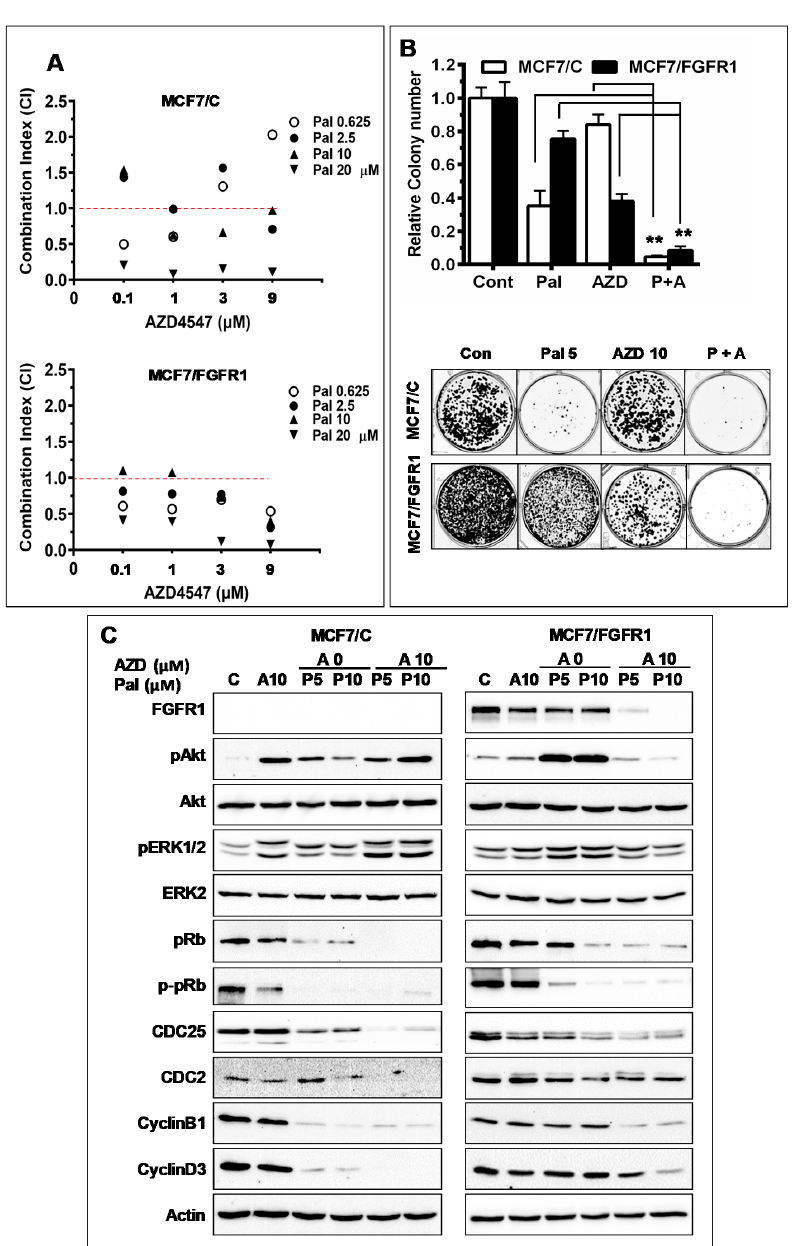
Figure 5. Effect of AZD4547 combination on palbociclib-induced inhibition of proliferation and sig- naling in MCF-7/C and MCF-7/FGFR1 cells. ( A ) Combination with AZD4547 synergizes palbociclib- induced inhibition of cell proliferation. MCF-7/C and MCF-7/FGFR1 cells were treated with pal- bociclib (0, 0.625, 1.25, 2.5, 5, 10, 20 µ M) ± AZD4547 (0, 0.1, 0.3, 1, 3, 9 µ M) for 5 days, followed by XTT assays. The survival fractions for each cell line were normalized to the control. The combination index (CI) of palbociclib and AZD4547 from the XTT assays for each cell line was calculated using CompuSyn software. The spots with CI < 1.0 indicate synergistic effect. ( B ) Effect of AZD4547 and palbociclib combination on clonogenesis. The MCF-7/C and MCF-7/FGFR1 cells inoculated for clonogenic assays were treated with palbociclib (5 µ M) and AZD4547 (10 µ M), alone or in combi- nation, for 2 weeks. The colonies were stained with crystal violet for imaging and analysis with Student’s t -test (** p < 0.01). ( C ) Western blot detection of key markers in RTK signaling and cell cycle regulation in palbociclib-treated cells. MCF-7/C and MCF-7/FGFR1 cells were treated with palbociclib (0, 5 µ M, 10 µ M) and AZD4547 (10 µ M), alone or in combination, for 48 h, followed by Western blot analysis of specified